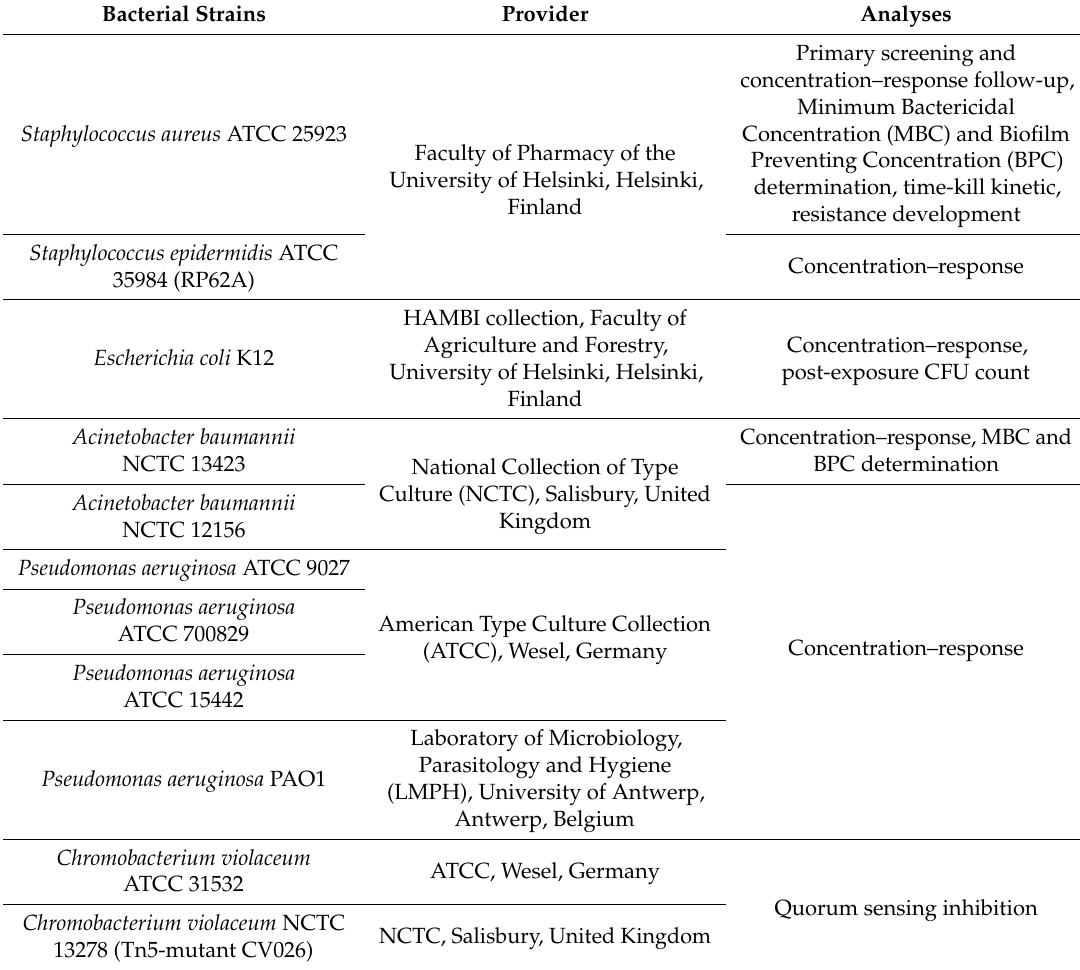
Table 1. Bacterial strains, providers and analysis performed with each strain. Bacterial Strains Provider